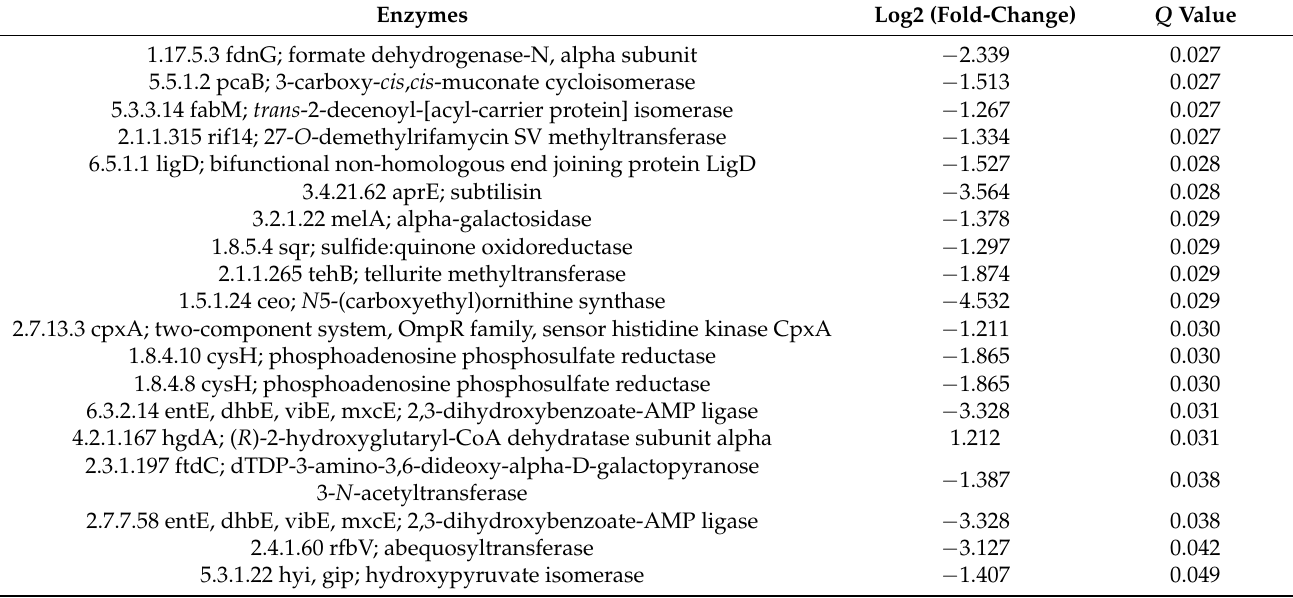
Table 4. Day 30 comparison of the enzyme levels of subjects demonstrating UV resistance following grape consumption ( n = 9) vs. subjects not resistant to UV irradiation following grape consumption ( n =